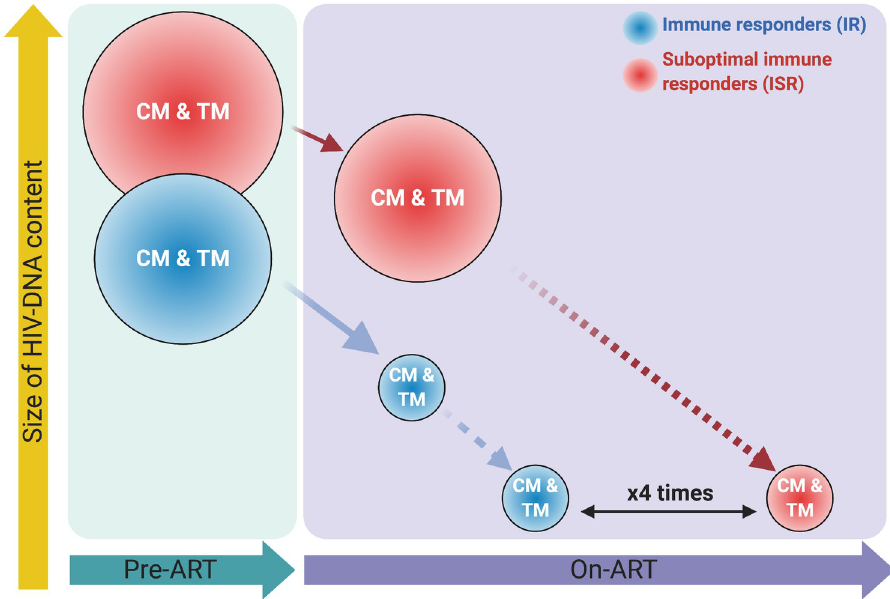
Fig 6. Schematic representation of latent reservoir dynamics after ART initiation over time in CM and TM CD4 T-cells from immunologic responders (IR; blue circles) and suboptimal immunologic responders (ISR; red circles). Size of the circles represents the level of co-IRs